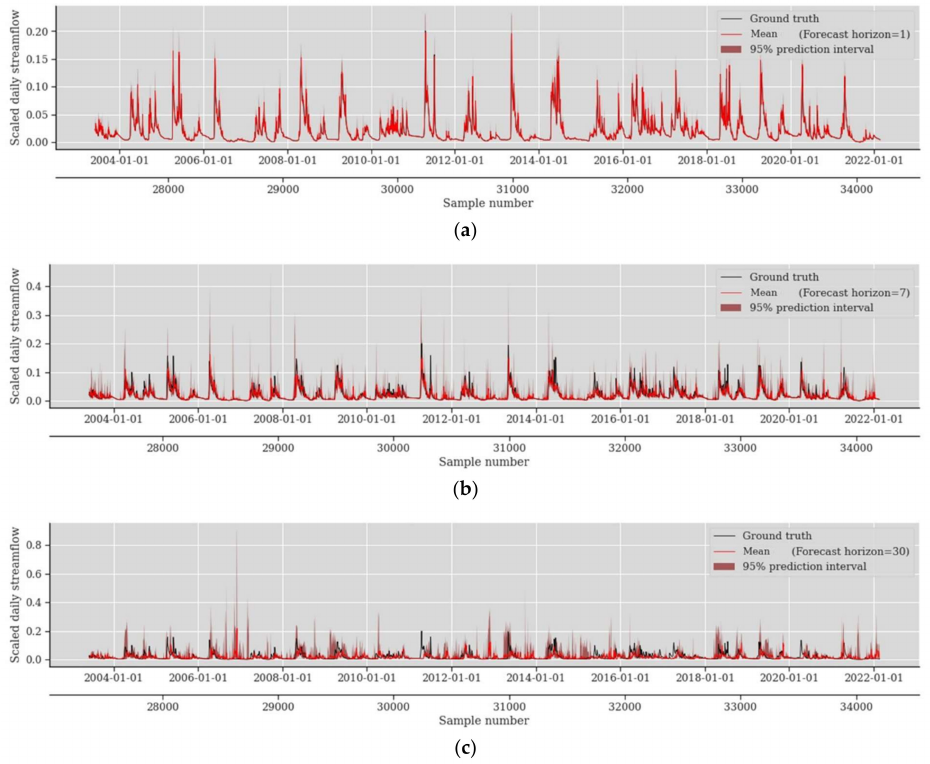
Figure 7. Probabilistic streamflow forecasting results obtained by BLSTM for case study II for